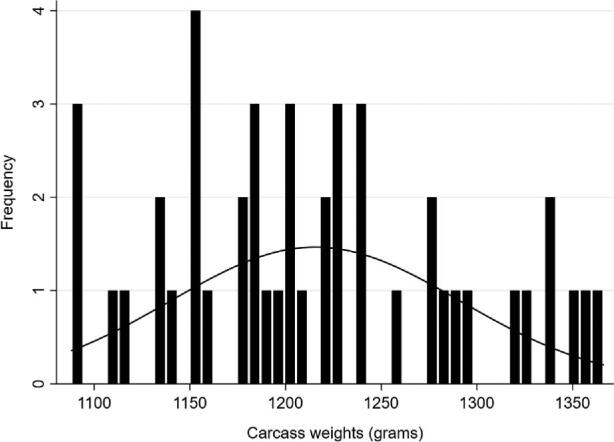
The distribution of carcass weights in the sample population (n = 45). The line represents the normal density plot.